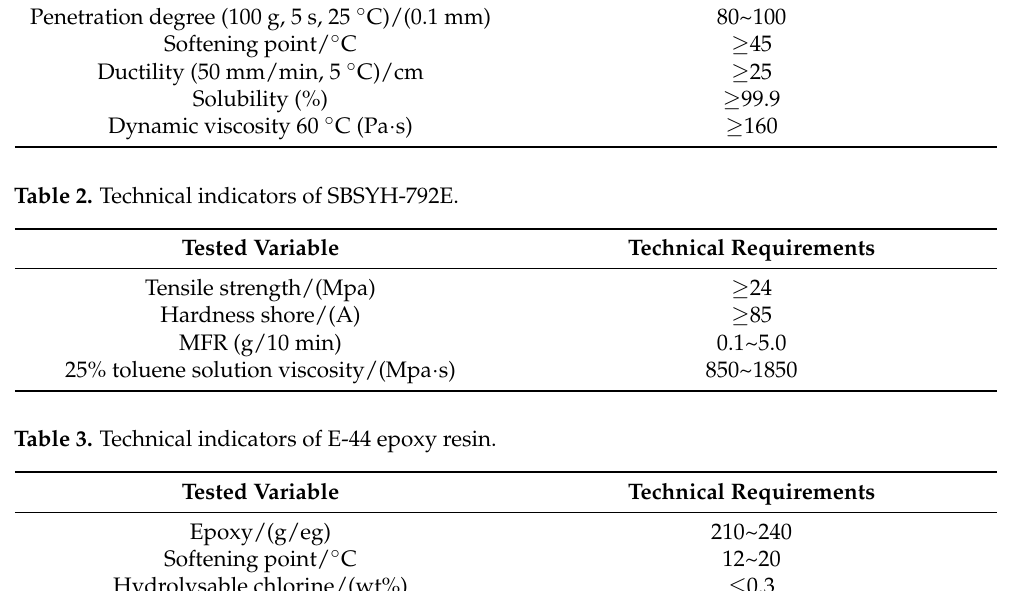
Table 1. Technical indicators of SK-90 matrix asphalt. Tested Variable Technical Requirements